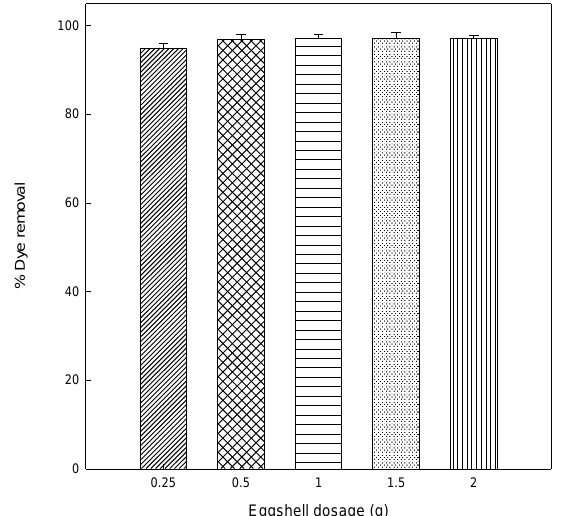
Figure 1. Effect of eggshell amount on the adsorption of Direct Blue 78 (DB78). Figure 1. E ff ect of eggshell amount on the adsorption of Direct Blue 78